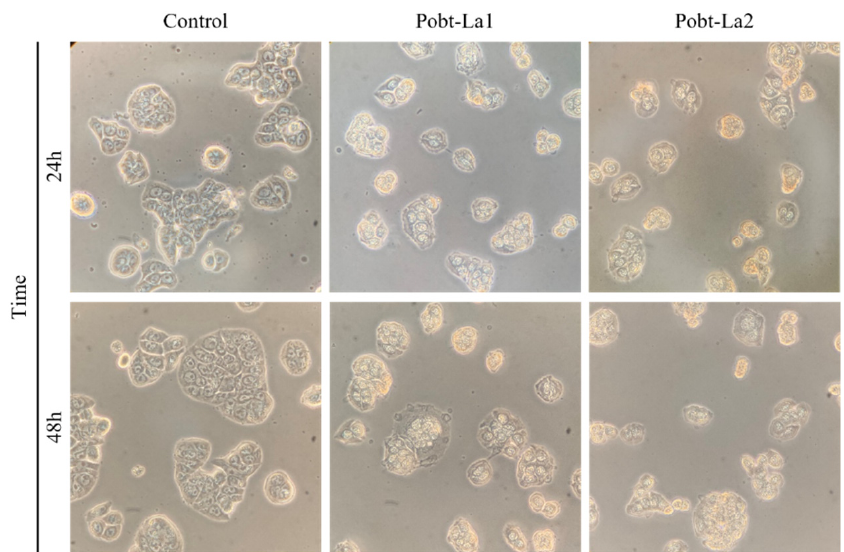
Figure 2. Morphological change of HT-29 cells by postbiotics. Table 2. Viability of HT-29 cells according to the concentration of postbiotics.